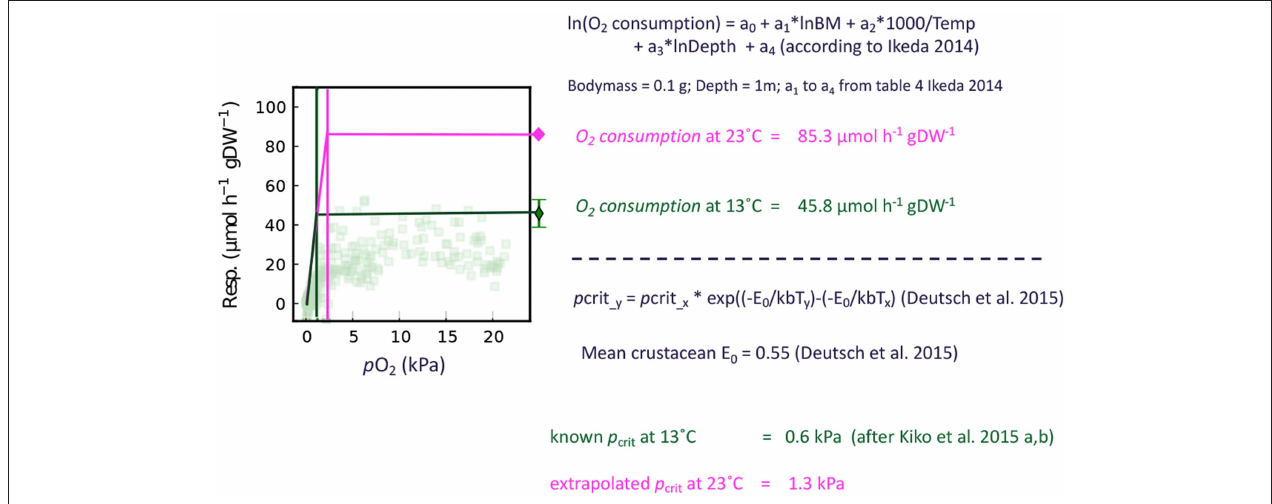
FIGURE 2 | Schematic of the respiration rate correction for environmental partial pressures below the p crit . The example calculations are conducted for Euphausiacea and the transparent dots in the figure indicate individual respiration rate measurements of E. mucronata from Kiko et al. (2016).